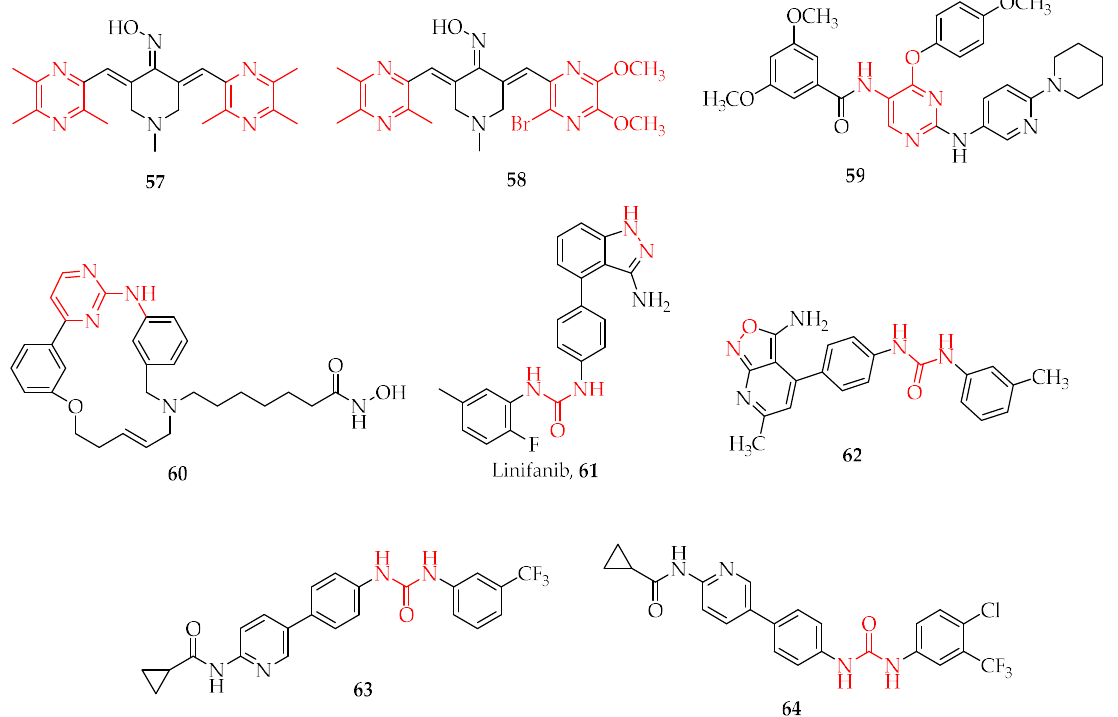
Figure 6. Derivatives of ligustrazine ( 57 , 58 ), 5-amino-4-pyrimidinol ( 59 ), N -(2-aminophenyl) benzamide acridine ( 60 ), Linifanib ( 61 ) and its isoxazol[3,4-b]pyridine-3-amino-derivative 62 , as well as other biphenyl-aryl urea derivative ( 63 and 64 ).